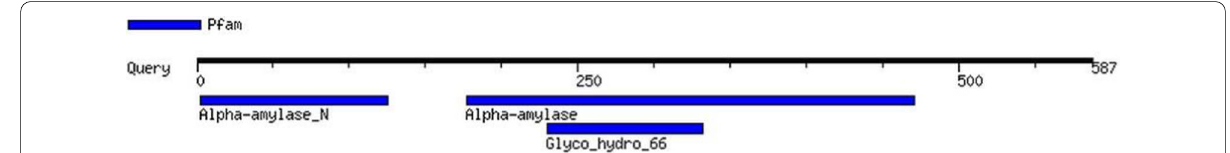
Fig. 1 Sequence analysis of the α-amylase Amy2587. The Pfam motifs are indicates by blue